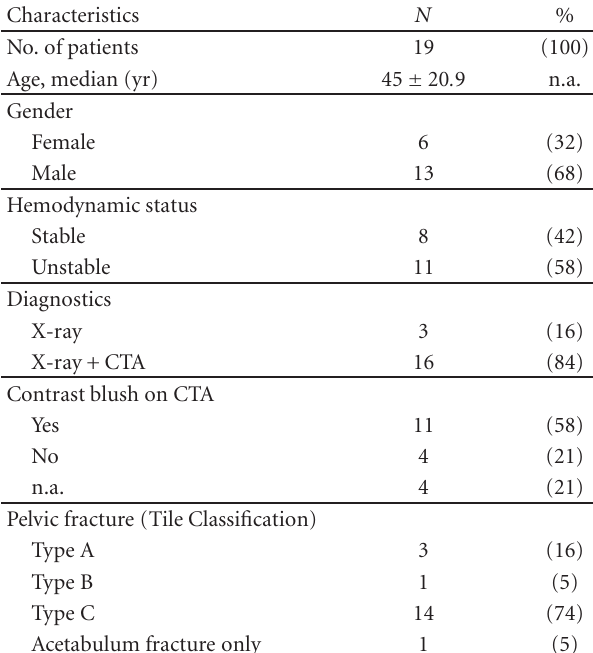
Table 1: Baseline